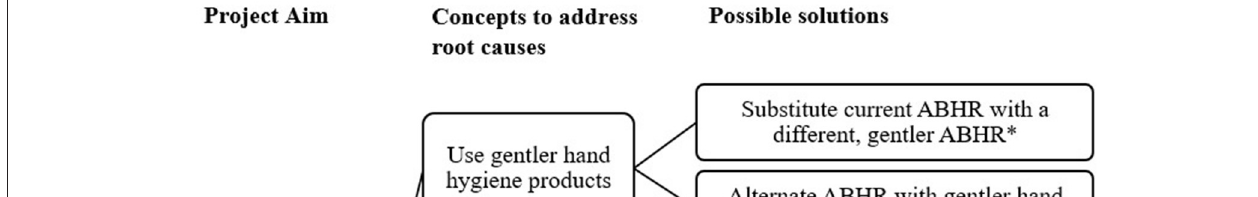
previously, before the COVID pandemic. A mild, germicidal wash lotion with added moisturiser was proposed for the hand wash alternative.